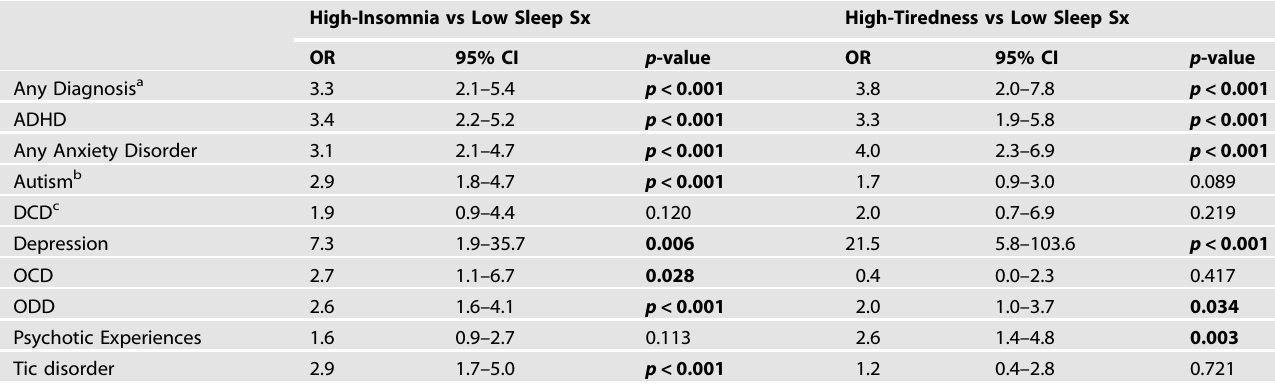
Supplementary Table 5 and Fig. 1 display for each ND-GC group the proportion of individuals who fall into each sleep class. Sleep class pro fi le was not found to signi fi cantly differ by ND-GC (overall χ 2 = 32.13; p = 0.124). However when sleep symptomatology was analysed as a continuous variable, each ND-GC group was found to have elevated total sleep symptom count compared to control siblings (mixed effect model, p < 0.05 for all contrasts with control siblings). Furthermore, within children with an ND-GC total sleep proportion of variance in sleep symptom count explained by